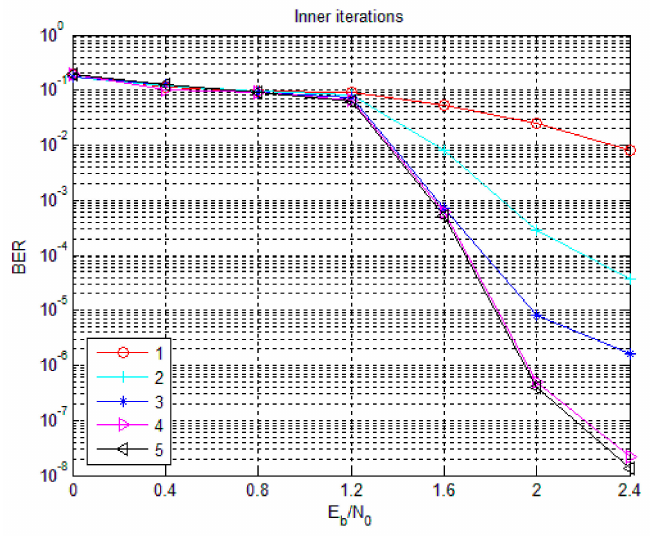
Figure 13. The influence of inner iterations on the performance of 8-ary LDPC-CPM